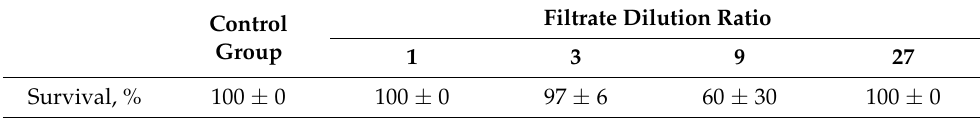
Table 2. Survival of Daphnia magna Straus (%) according to the results of exposure in the filtrate solution. Control